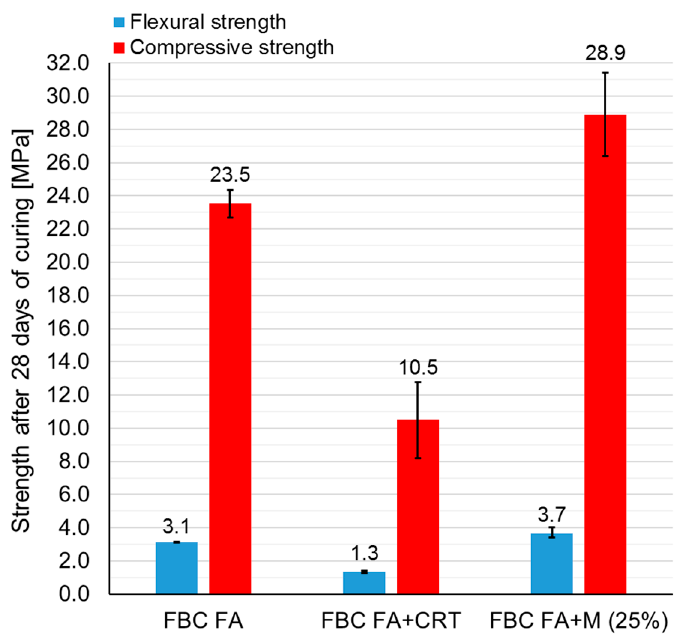
Figure 5. Flexural and compressive strength of geopolymer samples made of different mixtures (mean values for all series tested). Table 4. Standard deviation and coefficient of variation of series of samples tested after 28 days.